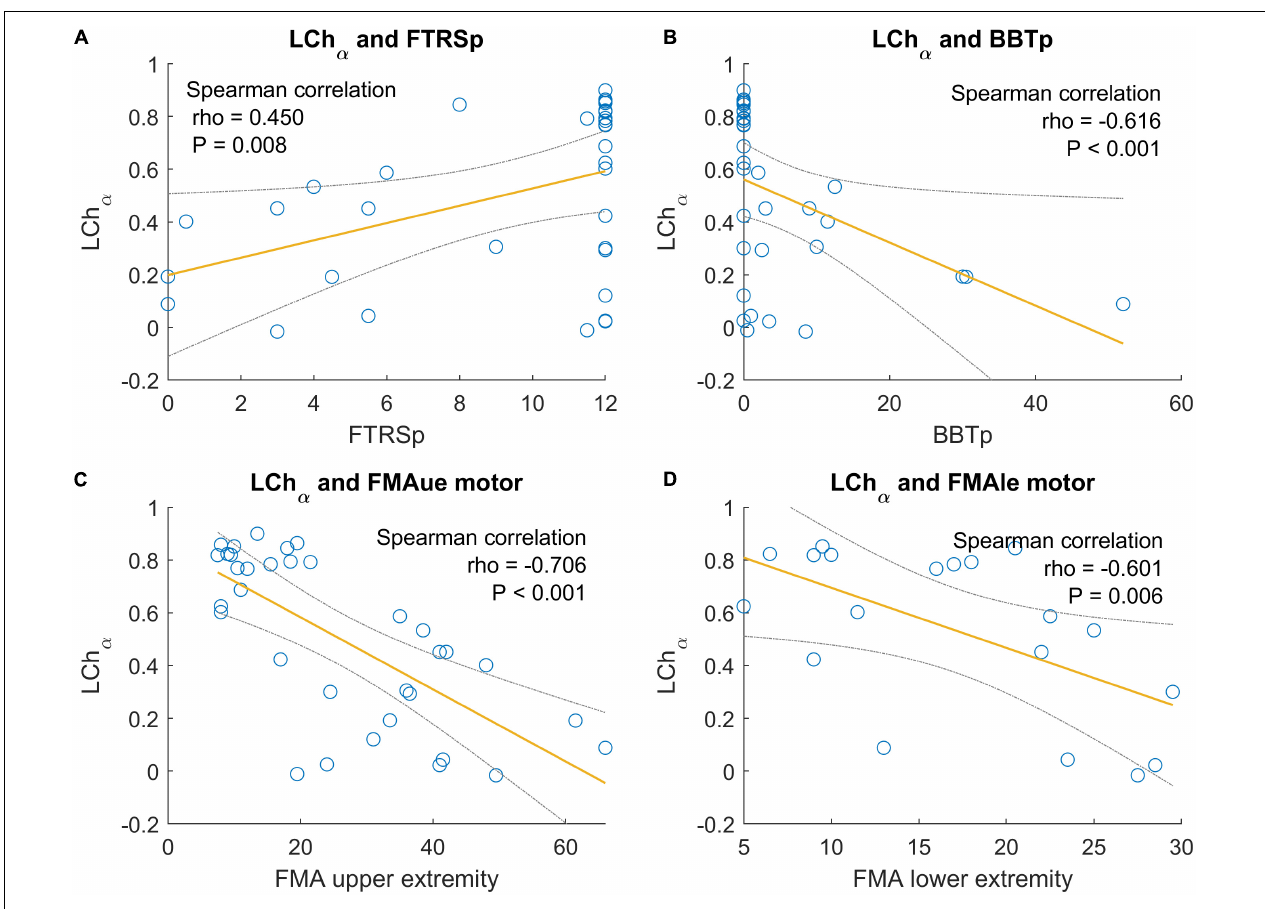
FIGURE 7 | Significant correlations between LC of the paretic hand in alpha band and functional scales. The gray lines are the confidence interval at 95%. (A) Correlation between LCh α and BBT of the paretic hand. (B) Correlation between LCh α and FTRS of the paretic hand. (C) Correlation between LCh α and FMAue of the motor part. (D) Correlation between LCh α and FMAle of the motor